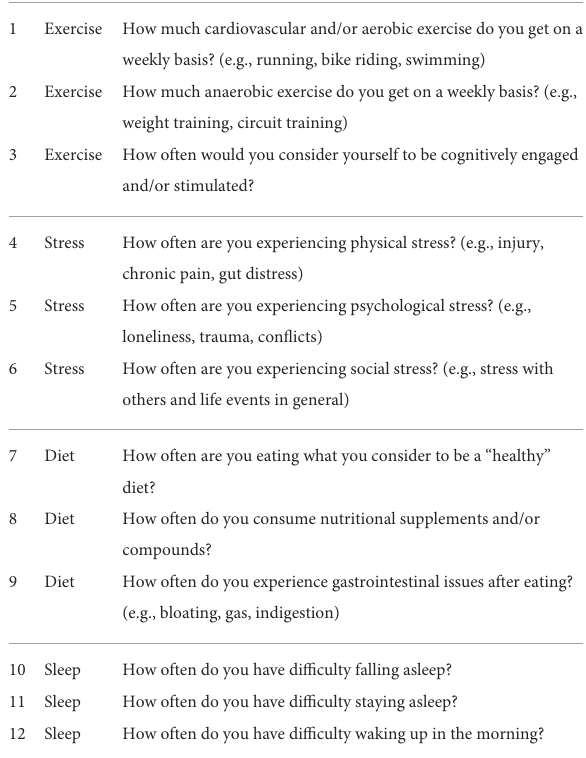
the cfa function. In no CFA model was there any evidence of irregularity in the optimization procedure, as each procedure exited normally within the default number of